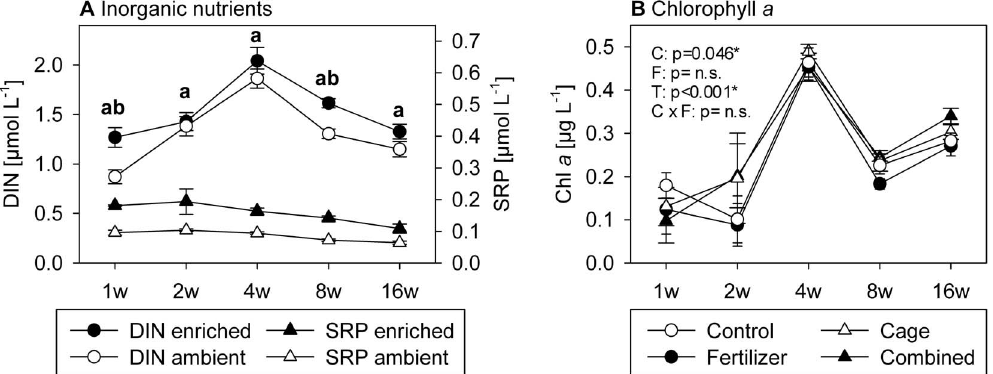
Figure 1. Inorganic nutrient (A) and Chlorophyll a (B) concentrations. A: Inorganic nutrient concentrations ( m mol L 2 1 ; means 6 SE) in the nutrient enrichment treatments (fertilizer & combined) and the non-enriched treatments (control & cage). Small letters (a for SRP; b for DIN) indicate statistical significant differences between enriched and non-enriched plots of p , 0.05 (t-test). DIN: dissolved inorganic nitrogen; SRP: soluble reactive phosphate. B: Chlorophyll a concentrations ( m g L 2 1 , means 6 SE) from water samples taken directly above the tile setups at all 5 sampling times. P- values were calculated from 3-factorial ANOVA and originate from analysis across the whole study period (see Table 1 for full results). P-values were tagged as n.s. (=not significant), when the model reduction step excluded the corresponding